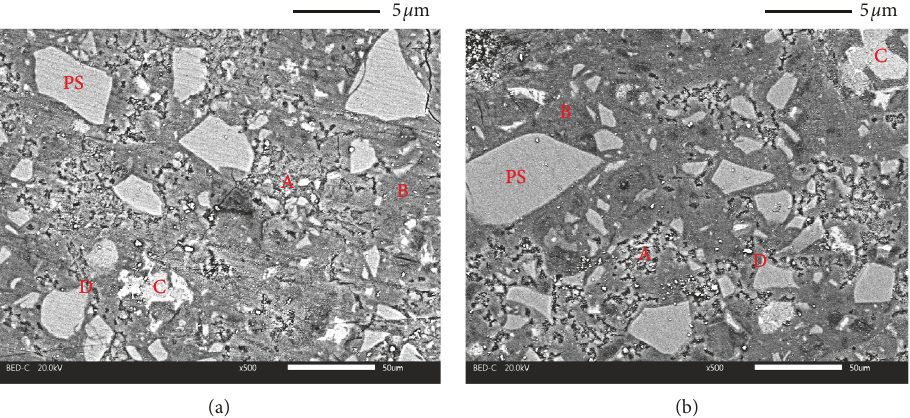
Figure 9: Typical BSE images of specimens hydrated for 90days. (a) PS40; (b) PS38NC2. PS: ground phosphorous slag grains; A: porous areas; B: dense areas; C: unhydrated cement grains; D: PS.